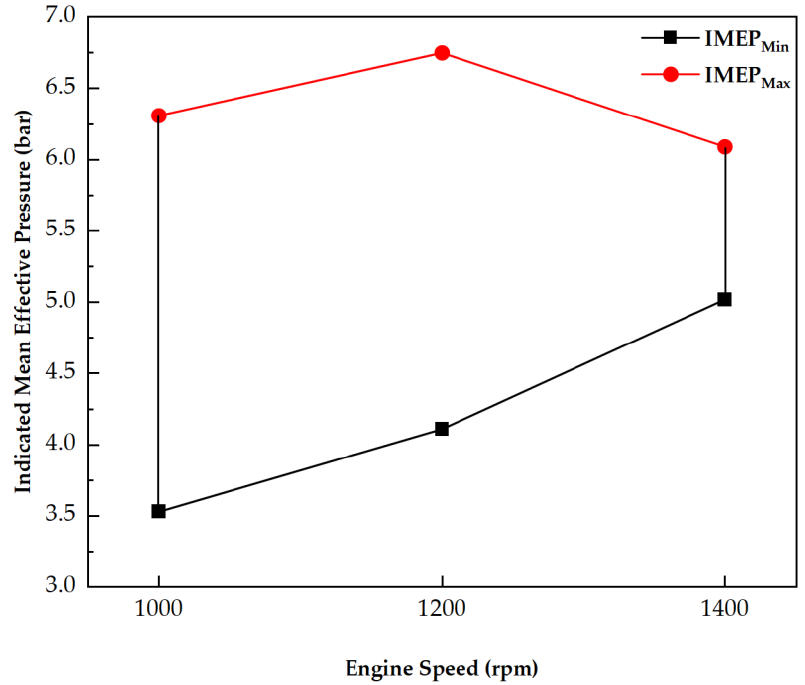
Figure 6. The range of IMEP at 1000 rpm, 1200 rpm and 1400 rpm.